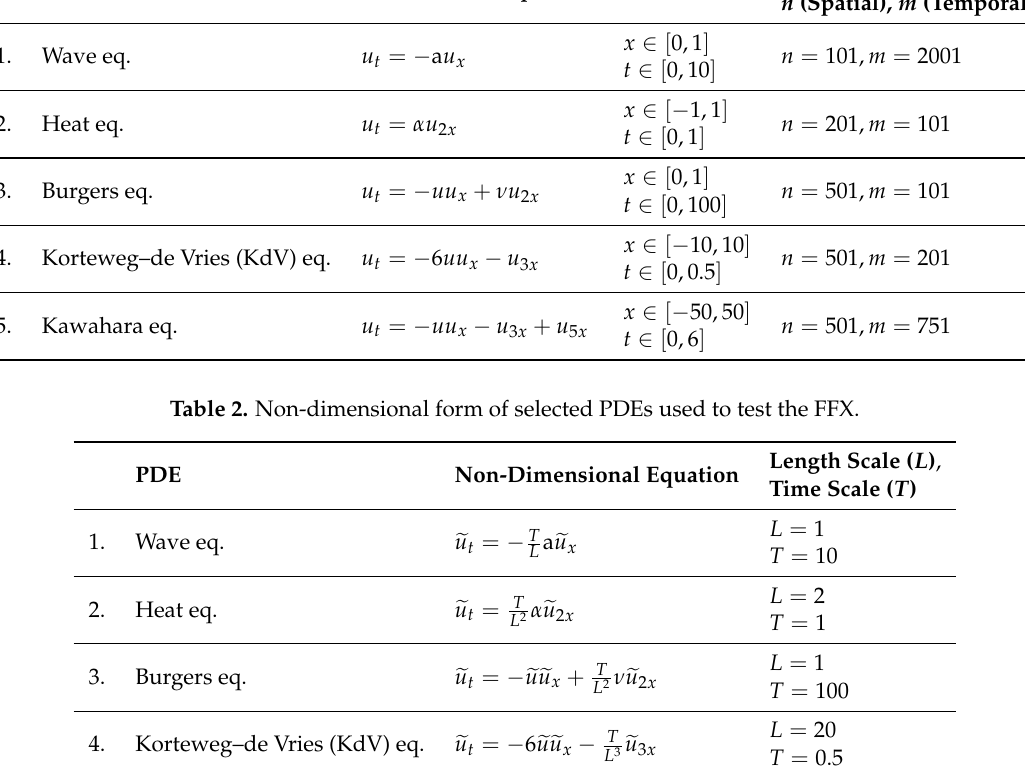
Table 1. Summary of different canonical PDEs selected for recovery using FFX. PDE Dimensional Equation Domain Wave eq.